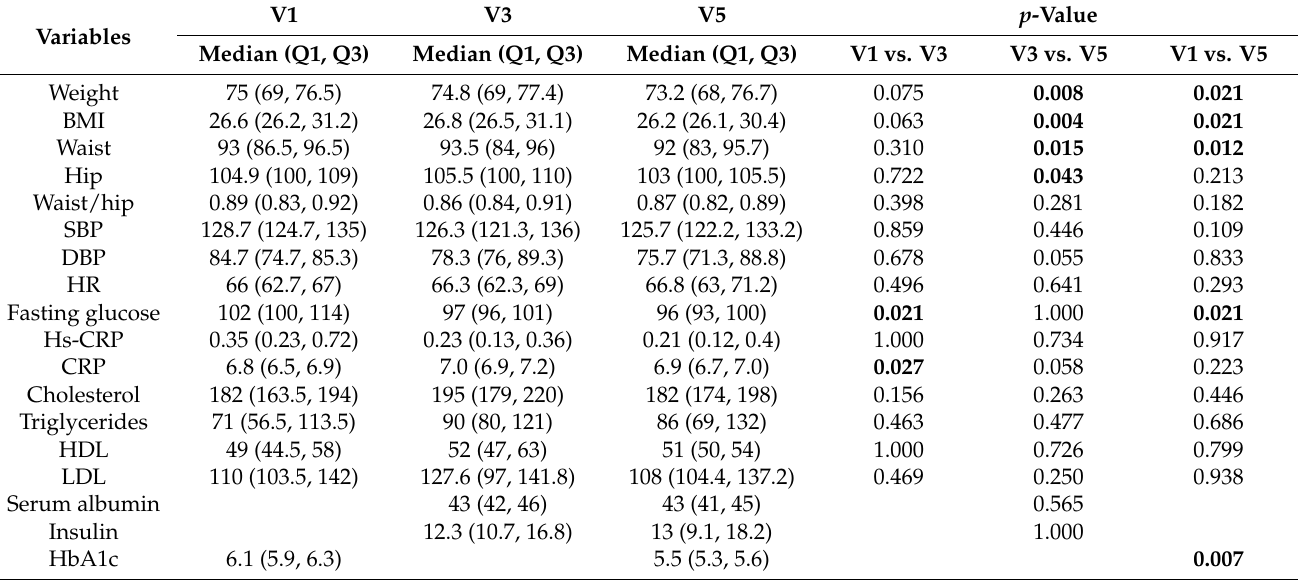
Table 1. Anthropometric measurements and blood test variables from 9